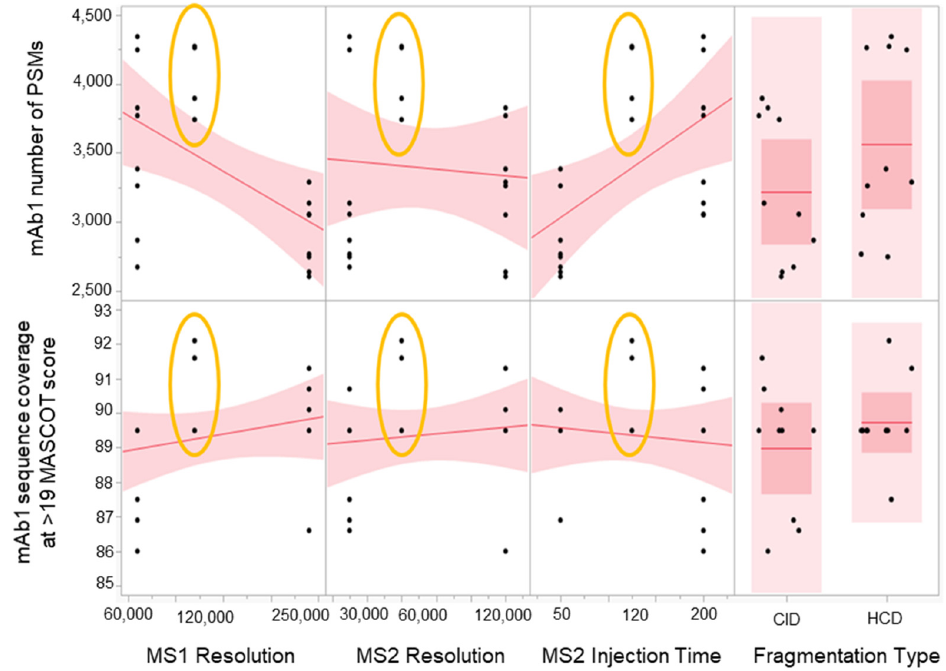
Figure 4. Scatterplot matrix showing the main effects of MS1 resolution, MS2 resolution, MS2 injection time, and fragmentation type on mAb1 PSMs and sequence coverage. Results from midpoints are encircled in yellow.